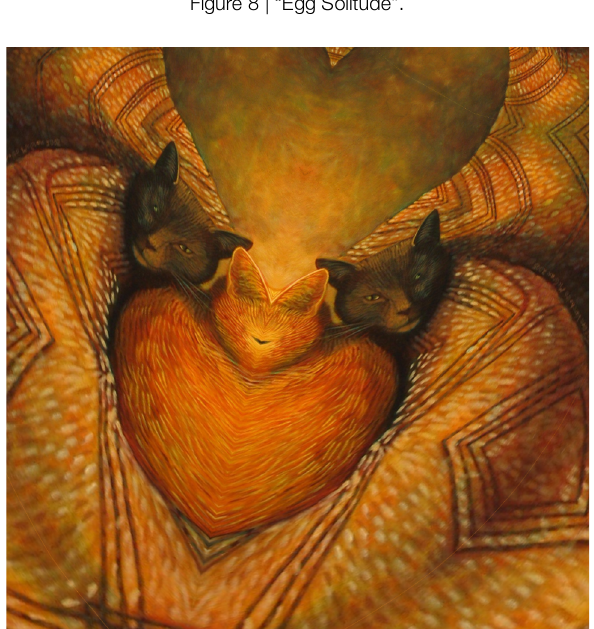
Figure 9 | “My Orange